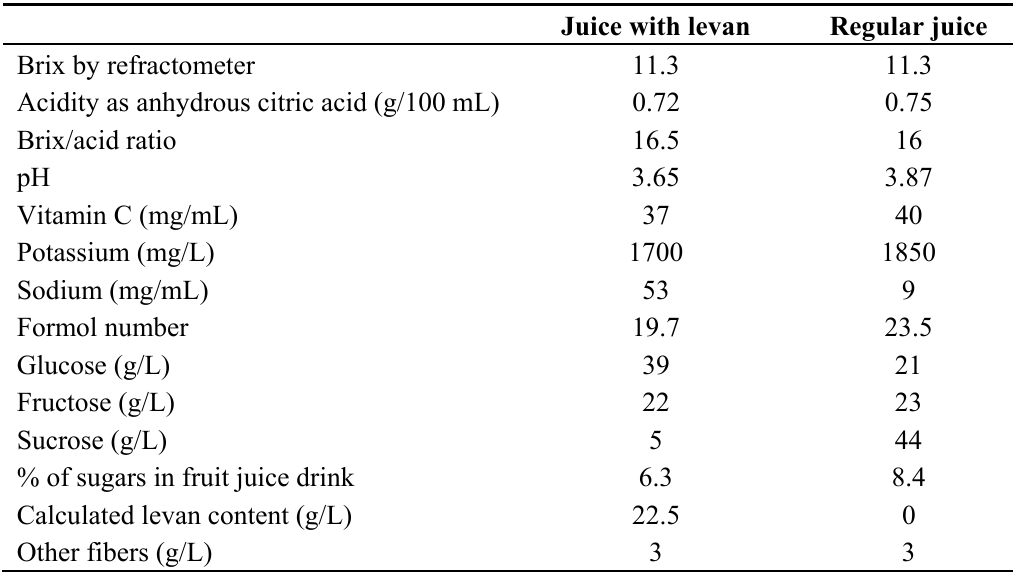
Table 1. Comparison between regular juice and levan-enriched